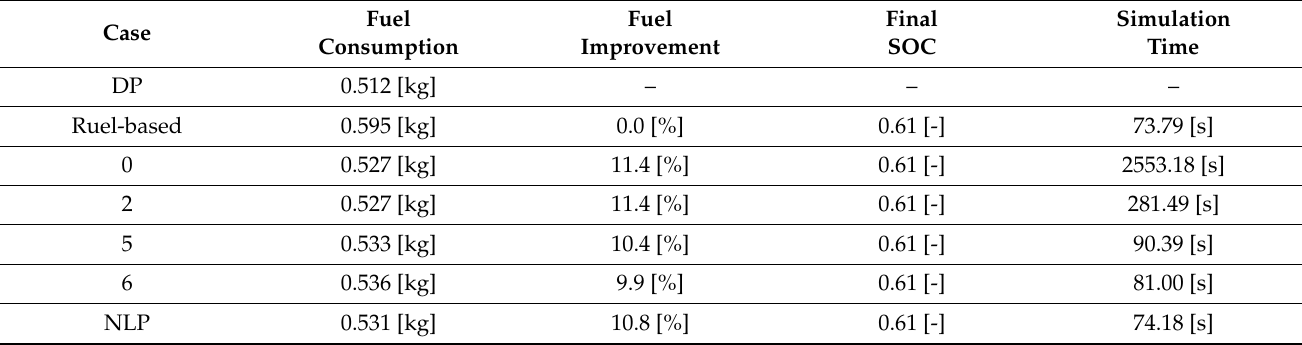
Table 4. Analysis of Autonomie simulation results: Fuel Improvement and Simulation